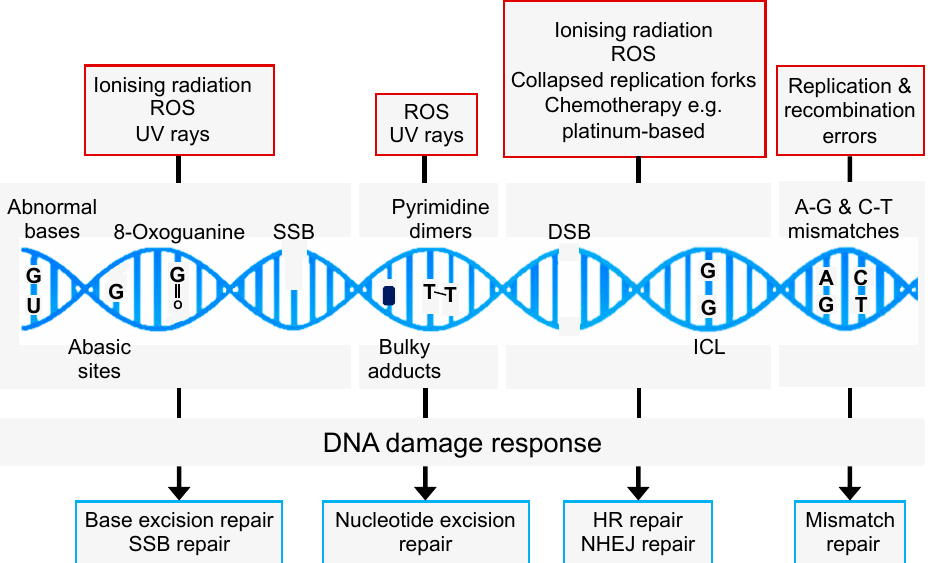
Figure 2. Common causes of DNA damage and repair pathways. Endogenous and exogenous DNA damaging agents promote a range of DNA lesions that are repaired by distinct and overlapping repair pathways. HR: homologous recombination; NHEJ: non-homologous end-joining; SSB: single-strand break; BER: base excision repair; ICL: interstrand crosslink.